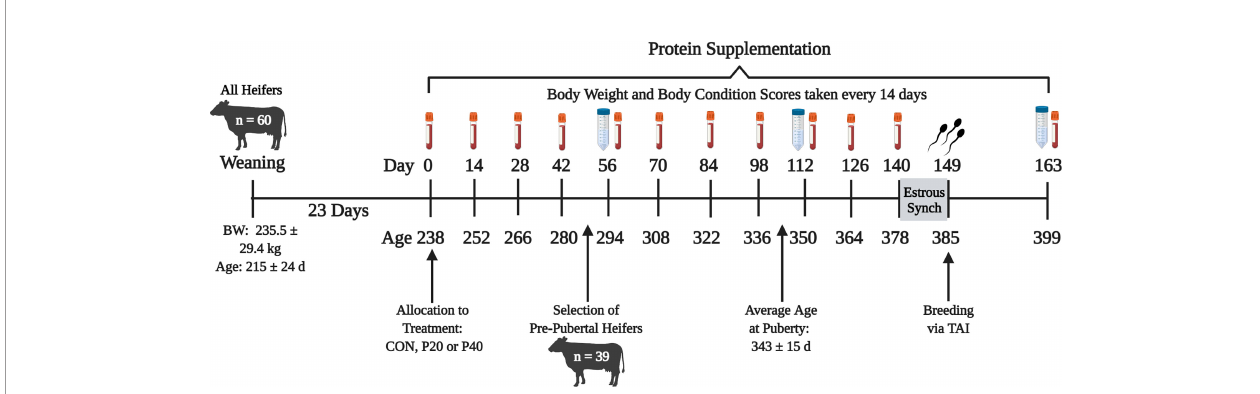
FIGURE 1 | Timeline of experiment beginning at weaning of all heifers until 2 weeks after breeding. Red tubes indicate blood samples every 14 days. Blue tubes represent uterine fl ush and rumen fl uid collection every 56 days. BW, body weight; CON, control 10% crude protein supplement; P20, 20% crude protein supplement; P40, 40% crude protein supplement; TAI, timed arti fi cial